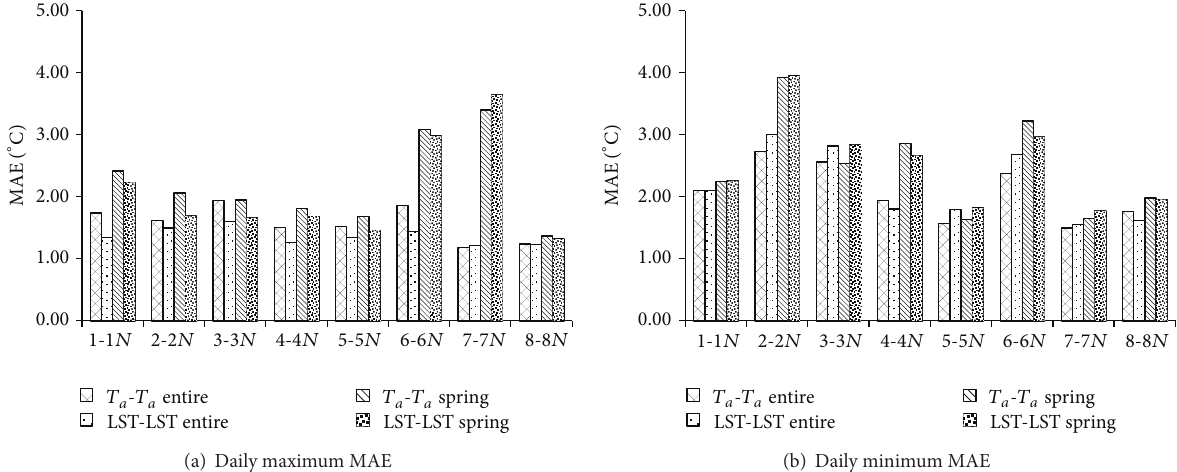
Figure 6: MAE values of daily maximum and minimum 𝑇 𝑎 creation results for 𝑇 𝑎 - 𝑇 𝑎 and LST-LST methods. In each group of bars, from left to right are 𝑇 𝑎 - 𝑇 𝑎 (entire period), LST-LST (entire period), 𝑇 𝑎 - 𝑇 𝑎 (spring), and LST-LST